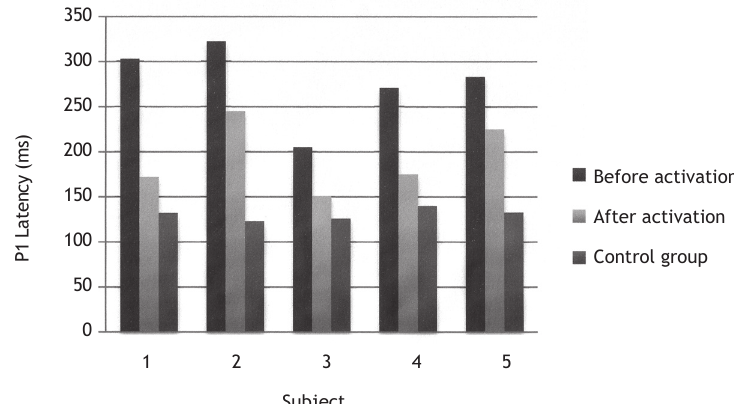
Figure 1 P1 component latency values before and after activation of cochlear implant electrodes of the study group compared to con - trol